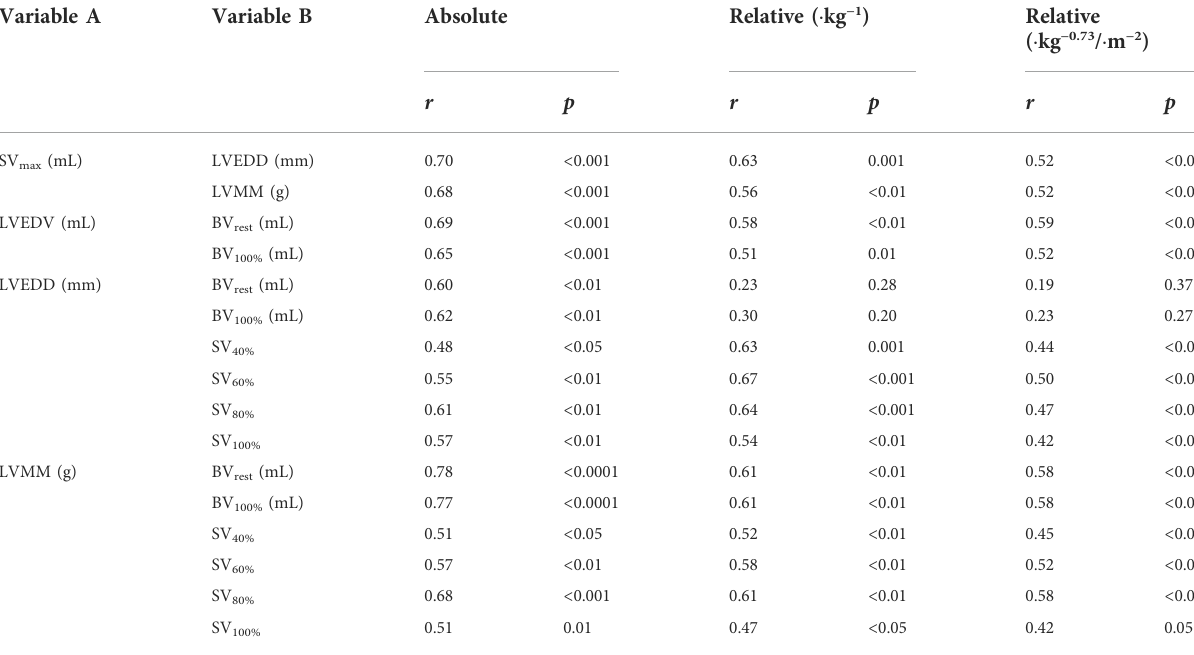
TABLE 4 Correlations ( r ) and levels of signi fi cance ( p ) between the absolute and relative values of SV, BV and cardiac dimensions. Variable